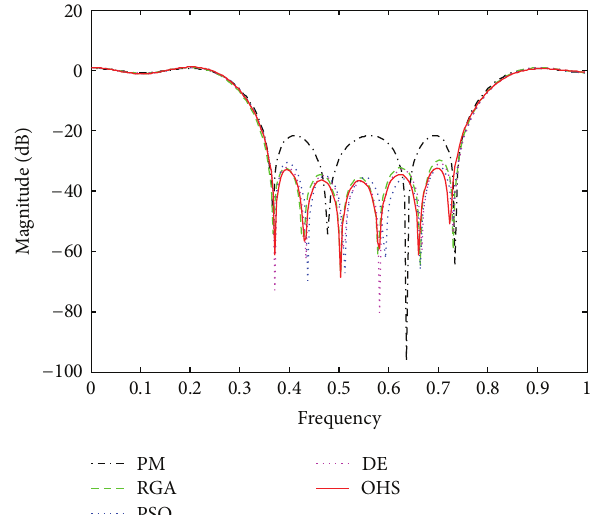
Figure 11: Normalized pass band ripple plots for the FIR BP filter of order 20.